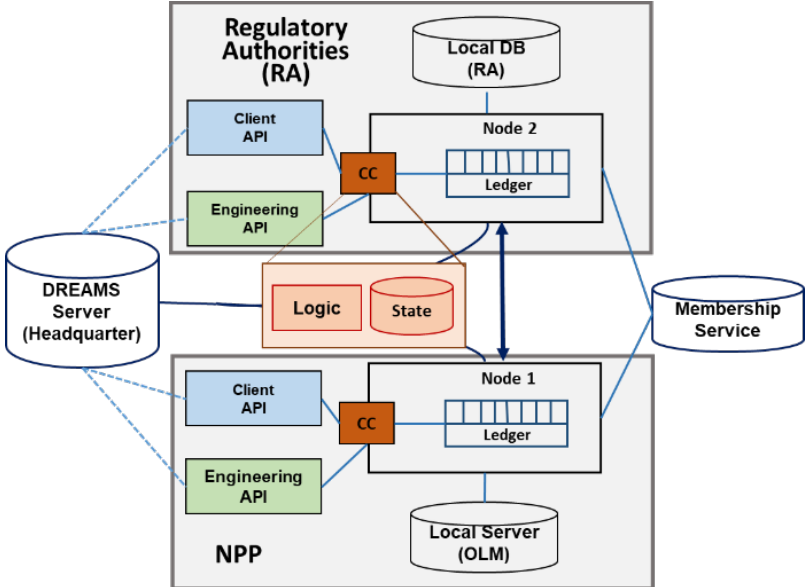
Figure 3. Blockchain for the plant management system (PMS) framework. NPP: nuclear power plant.